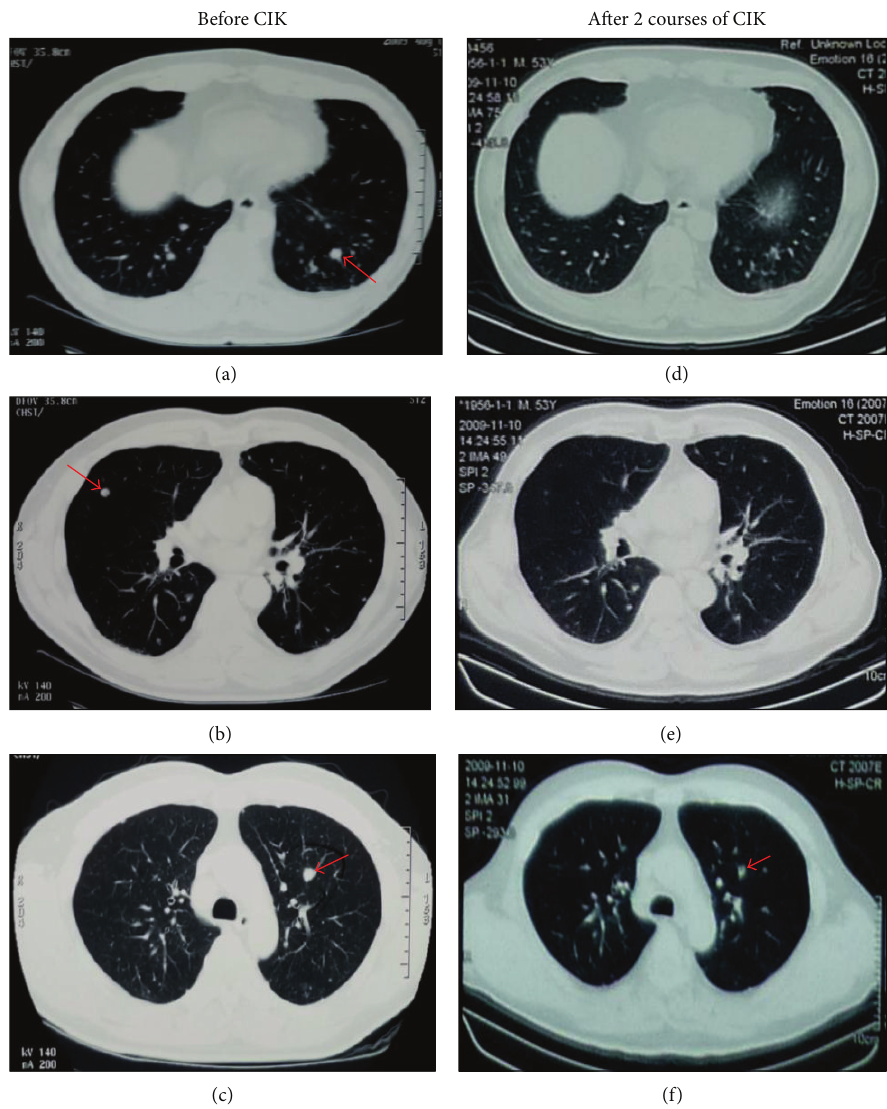
Figure 4: Example of chest CT before and after CIK cell treatment. ((a)–(c)) Images from Unique Patient Number (UPN) 7, who was diagnosed with pulmonary metastasis after radical nephrectomy and before CIK cell treatment. ((d)–(f)) Images from the same patient after two courses of CIK cell treatment. (a) A solid space-occupying lesion (0.9 × 1.2cm) was observed in the left lung. (b) A circular lesion (0.5 × 0.5 cm) with high density and clear boundary was observed in the right lung. The CT value was 22 Hu in the plain scan. (c) The image shows a space-occupying lesion (1.1 × 0.9 cm) with a high density signal and a clear boundary. (d) After two courses of CIK cell treatment, the tumor burden in the inferior lobe of the left lung was significantly reduced (compared to the corresponding image in (a)). (e) Chest CT indicated almost complete absence of lesions in the left lung corresponding to the image shown in (b). (f) Shrinking of lung metastatic lesions was